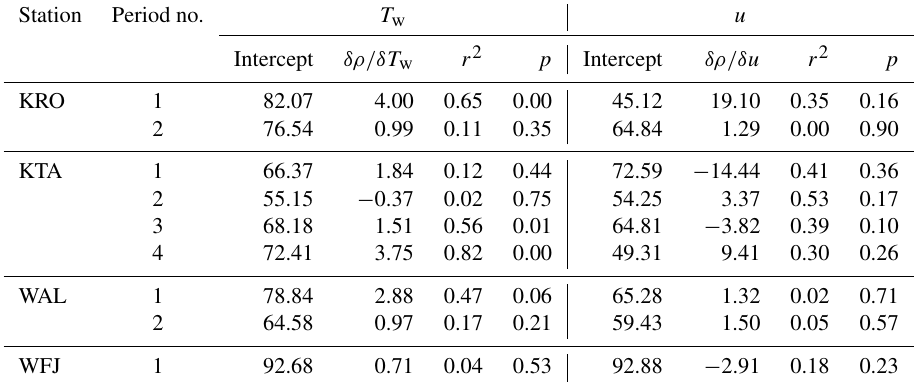
Table 3. Results of a single linear regression between the corrected densities ( ρ HN ) as a dependent variable and wet bulb temperature ( T w ) and wind speed ( u ) as explanatory variables for the class median values based on all filtered data points binned into 0.5 ◦ K classes and classes of 0.5ms − 1 , respectively. The corresponding coefficient of determination ( r 2 ) and the p value are presented. Station Period no. T w u Intercept δρ/δT w r 2 p Intercept δρ/δu r 2 p KRO